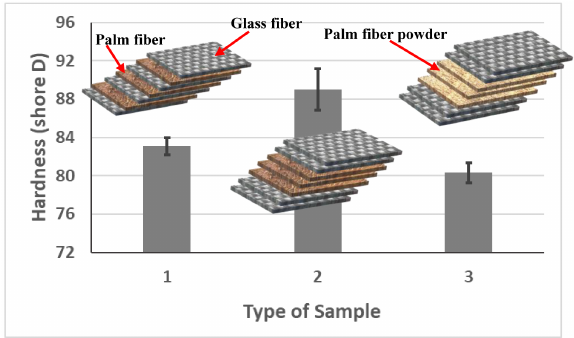
Fig. 7. The effect of fiber layers (stacking sequence and form) on the impact